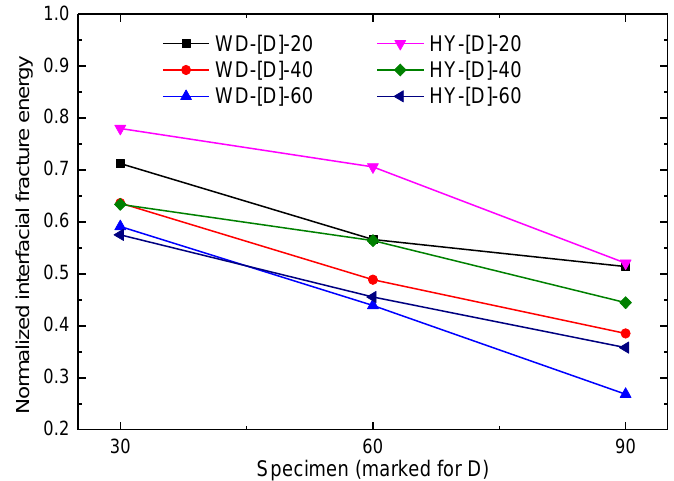
Figure 13. Interfacial fracture energy of the test specimens.